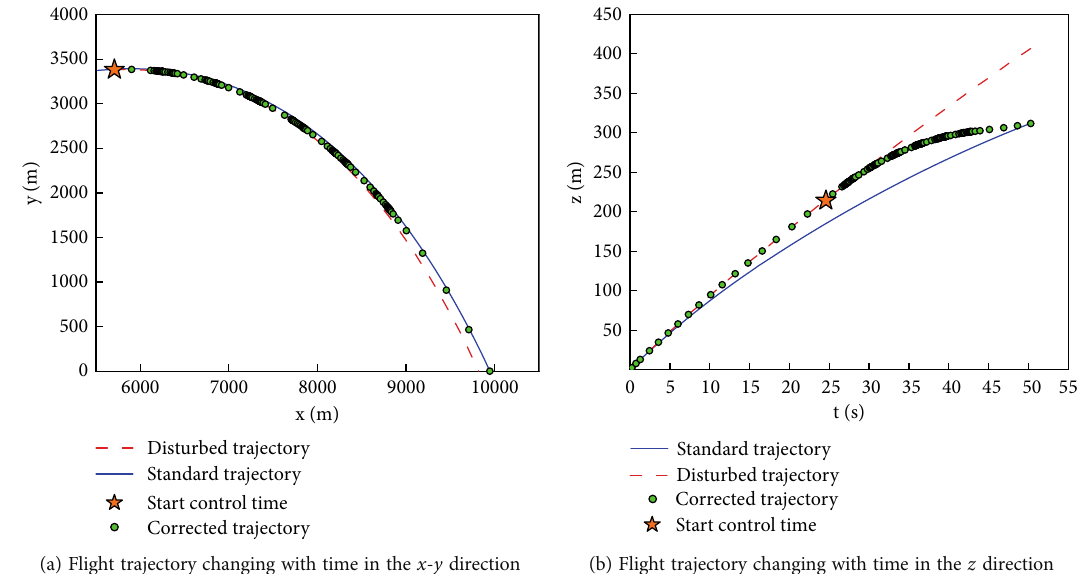
Figure 12: Comparison of trajectory curves in di ff erent directions.